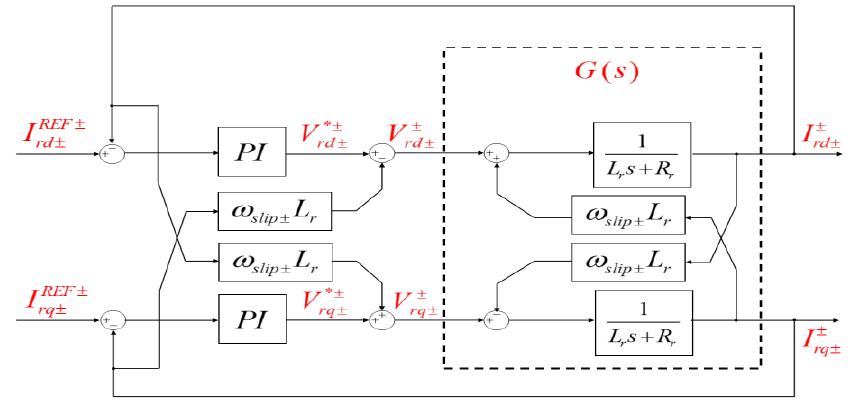
Fig. 1. DFIG open stator rotor current controller Figure 5. DFIG open stator rotor current Figure 5. DFIG open stator rotor current controller.